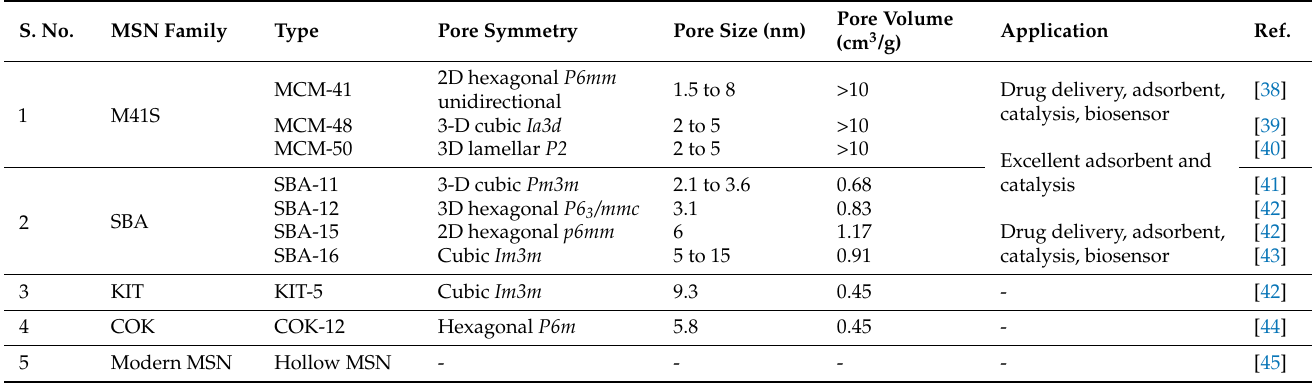
Table 1. Types of MSN used for drug delivery